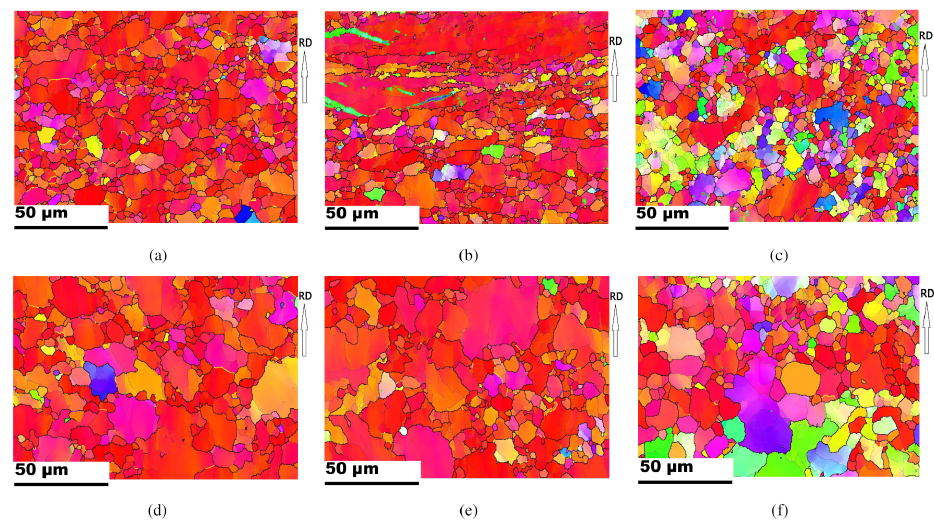
Figure 10. IPF maps of Part1, Part 2 and Part3 regions of drawn cups. The punch speed and working temperature were 30mm/min and 350 ◦ C, respectively. ( a ) Part 1, ( b ) Part 2, and ( c ) Part 3 for TRC sheets. ( d ) Part 1, ( e ) Part 2, and ( f ) Part 3 for IC sheets.